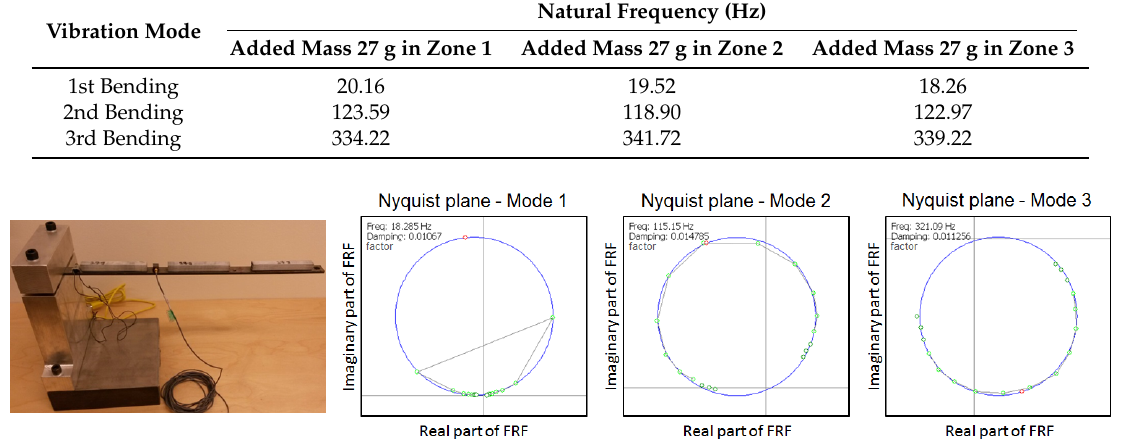
Figure 12. Natural frequencies and damping factors estimated from experiment using circle fit method in the added mass Case